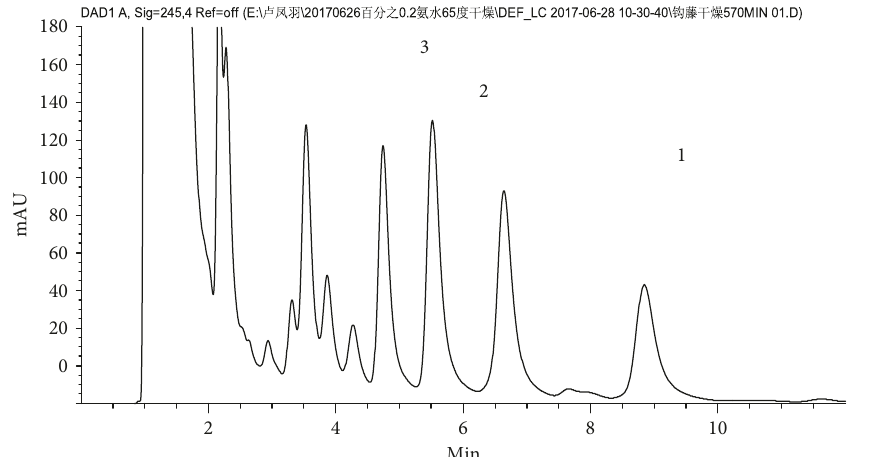
Figure 3: HPLC spectrum of drying process of sample collected at 80min (1, rhynchophylline ; 2, isorhynchophylline ; 3, corynoxeine